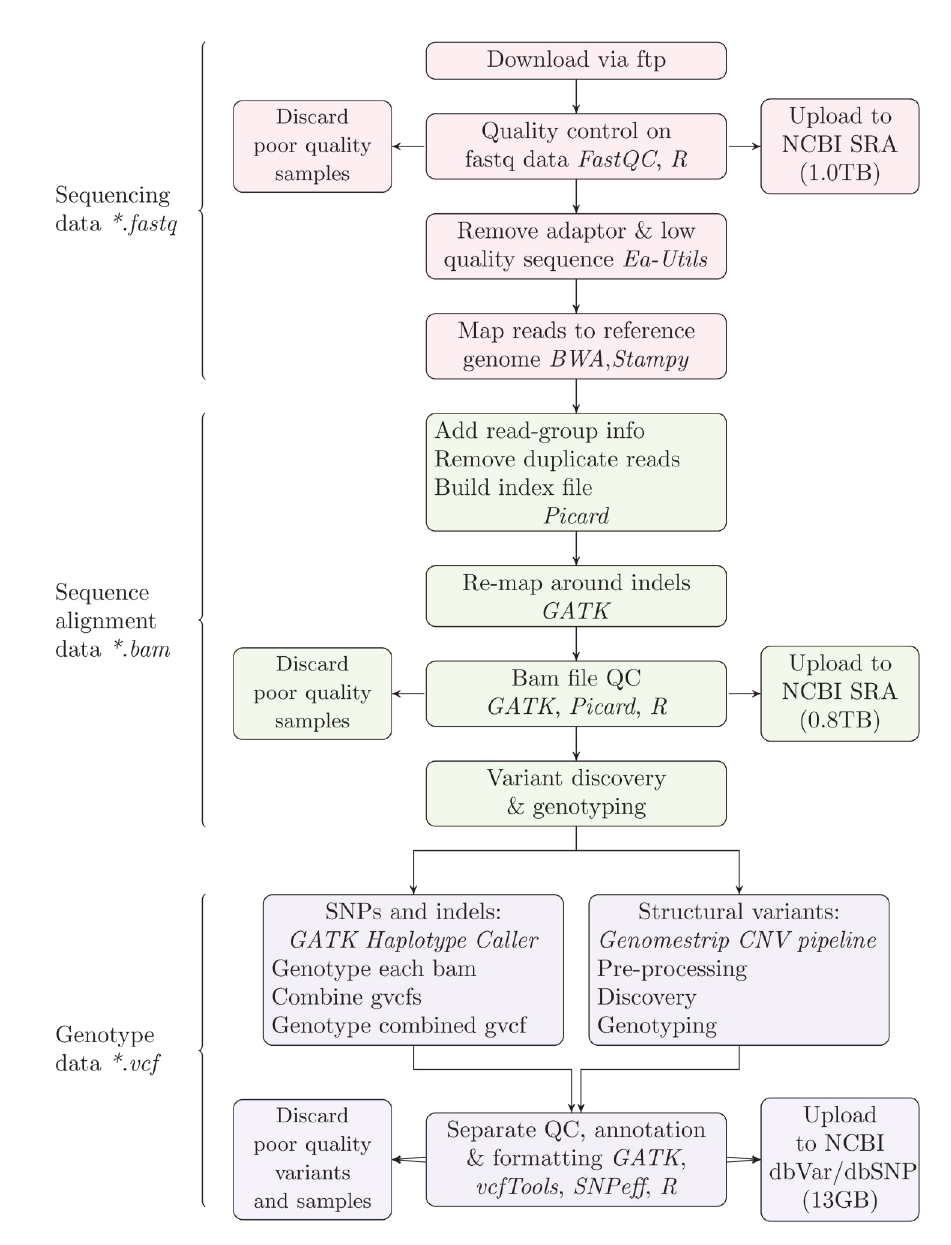
Figure 2. Flow diagram for the high-throughput sequencing data analysis. Data file types are indicate at the left side. Nodes are also coloured by file type. Software platforms are in typed in italics. Values in parentheses indicate the size of the data uploaded at different stages. Latex code for generating this figure is available at